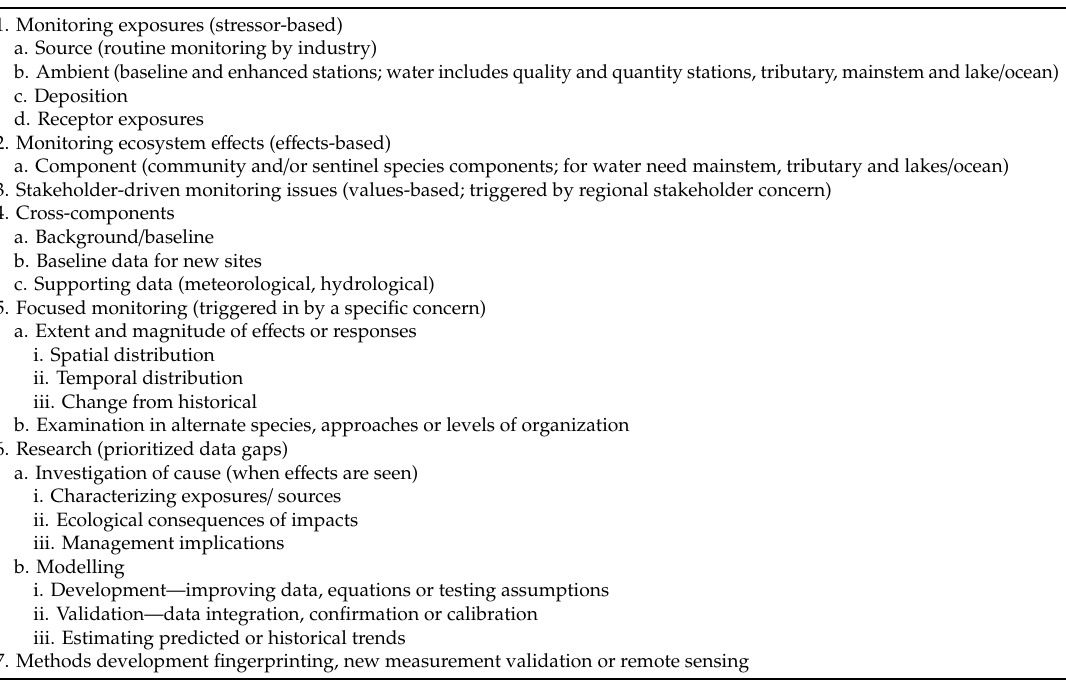
Table 4. A breakdown of components of an idealized regional monitoring